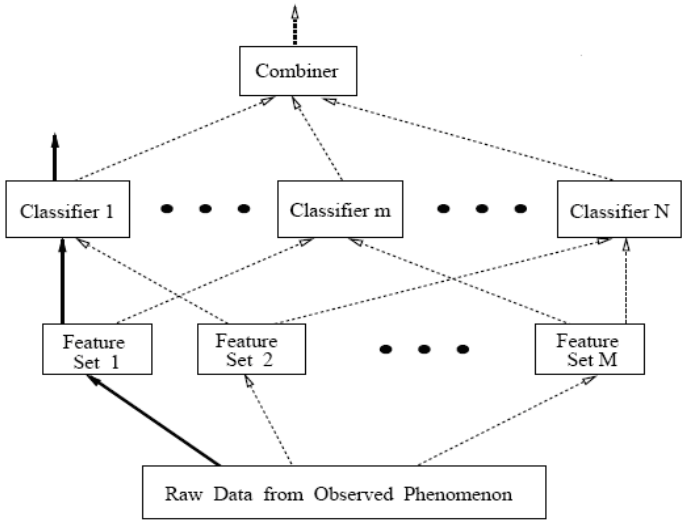
Figure 2. General framework of classifier